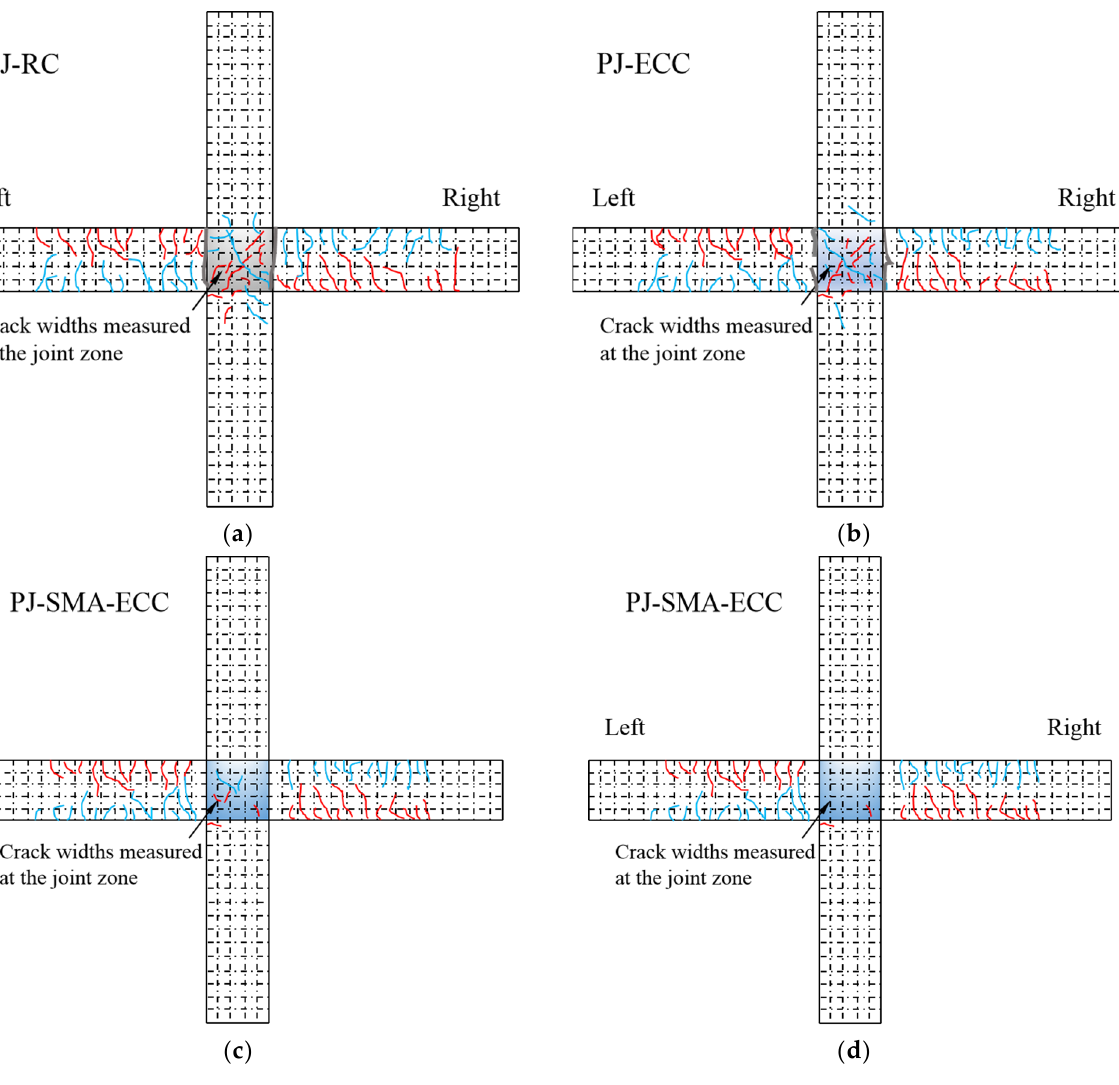
Figure 7. Crack patterns of specimens. ( a ) J-RC; ( b ) PJ-ECC; ( c ) PJ-SMA-ECC; ( d ) Self-healed PJ-